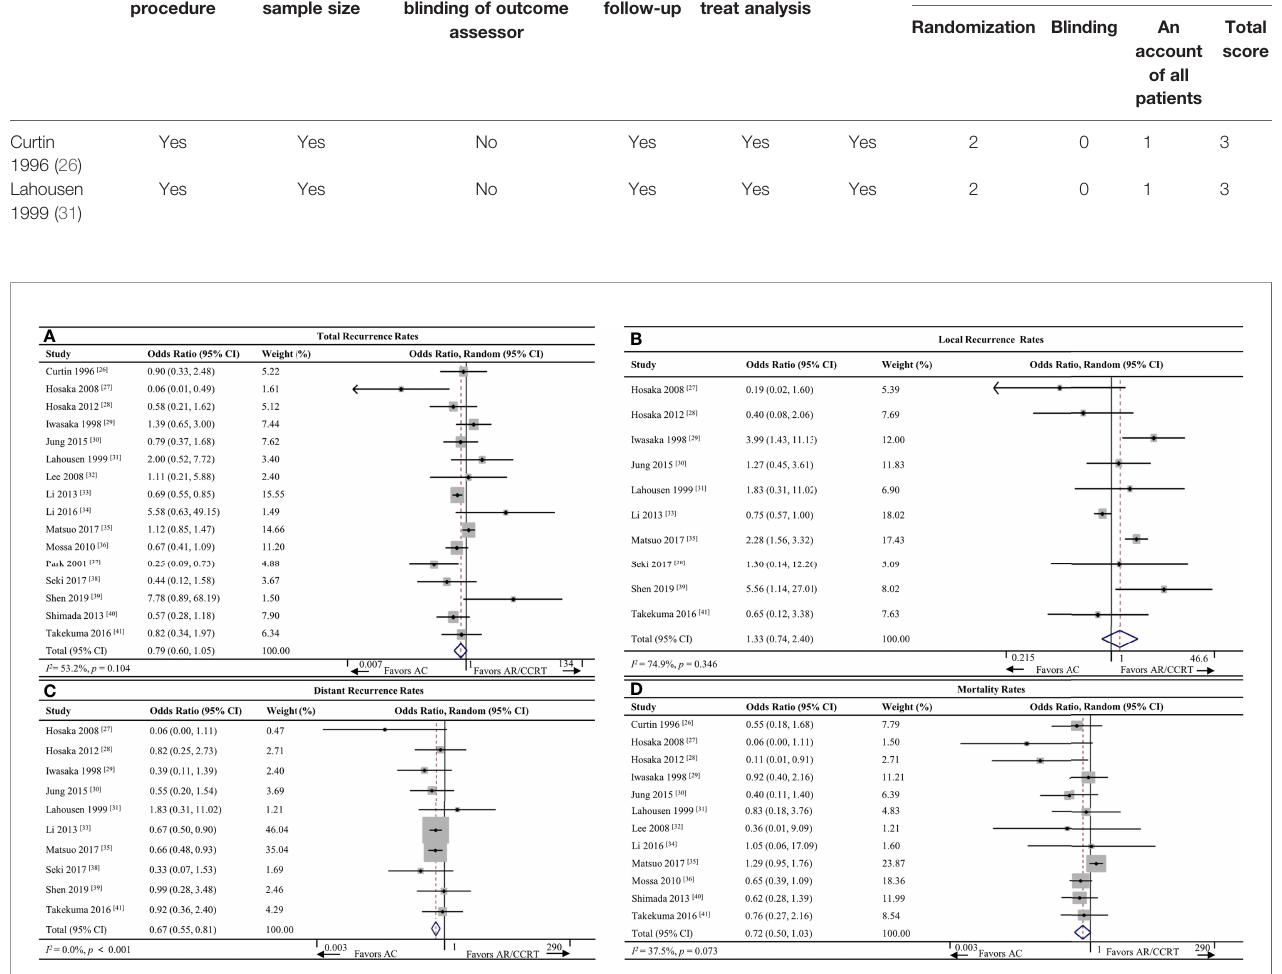
TABLE 3 | Jadad score for assessing risk of bias and quality of randomized controlled trials.